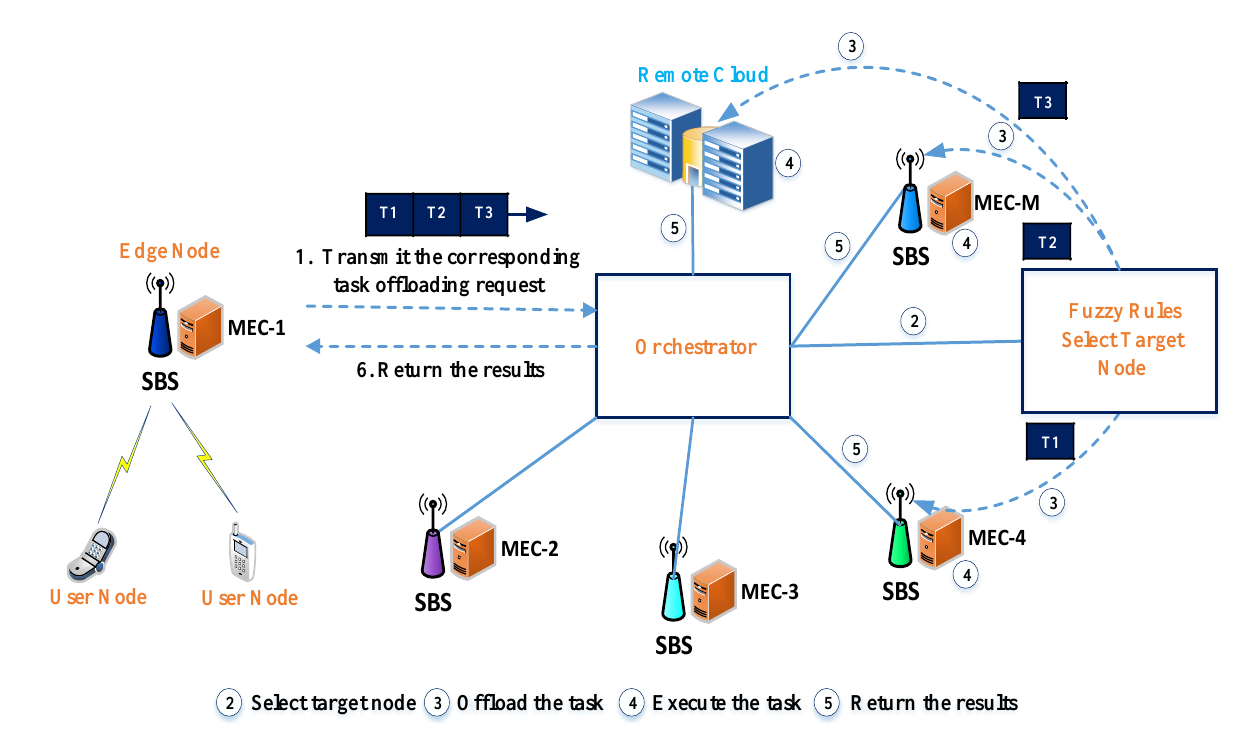
Figure 4. The role of the orchestrator and the flow of the task offloading